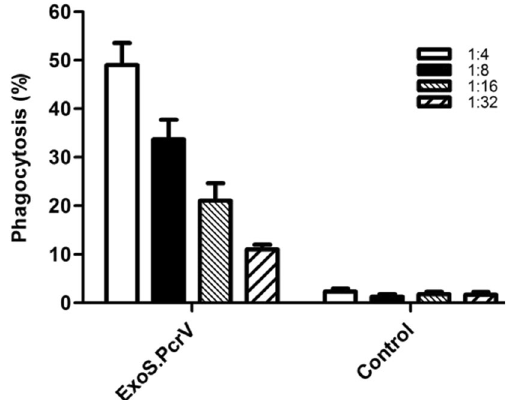
Figure 4. The opsonic killing activity of anti-ExoS.PcrV against P. aeruginosa strain PAO1. The P. aeruginosa strain PAO1 was incubated with four dilutions of anti-ExoS.PcrV, mice macrophage and rabbit complement. A significant opsonic killing activity was observed when anti-ExoS.PcrV was used as compared to the control group (49% vs. 2.33%). Data are the mean ± S.D. from three independent